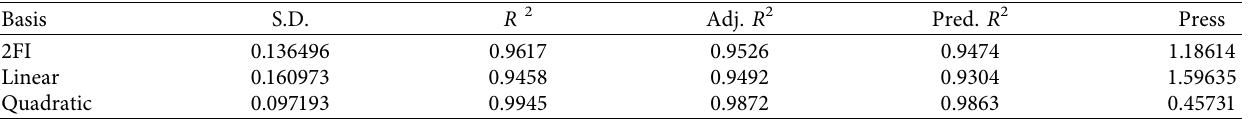
Table 5: Te model’s statistical